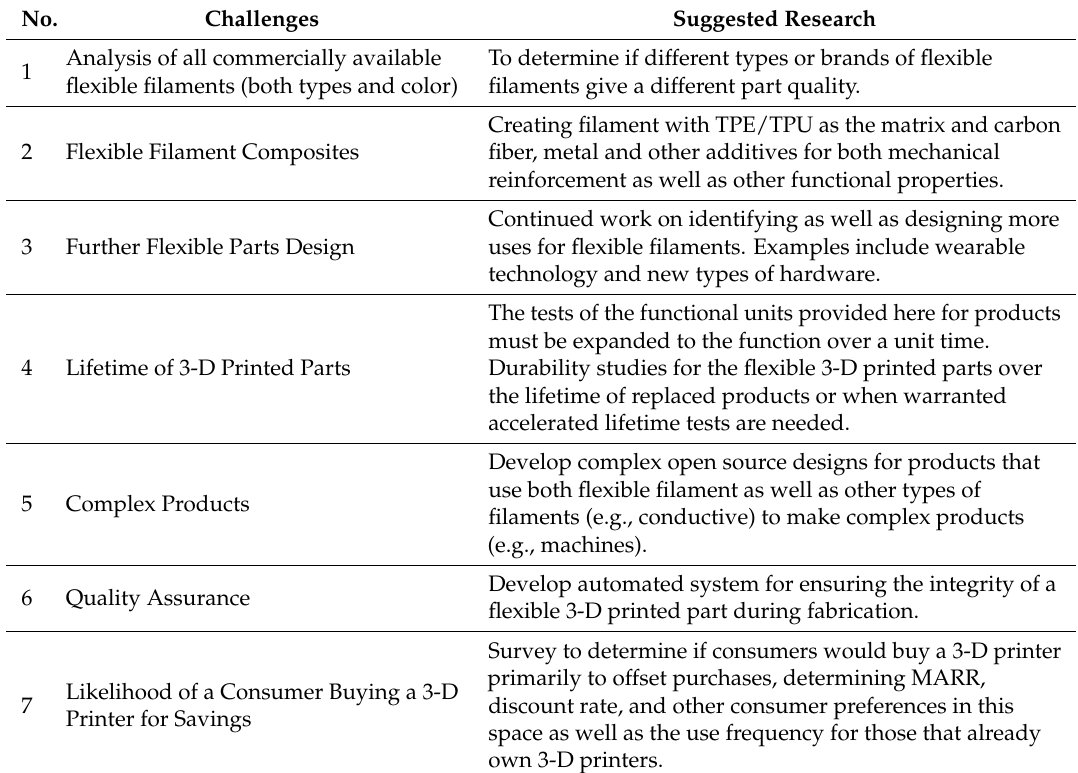
Table 6. Directions for Further